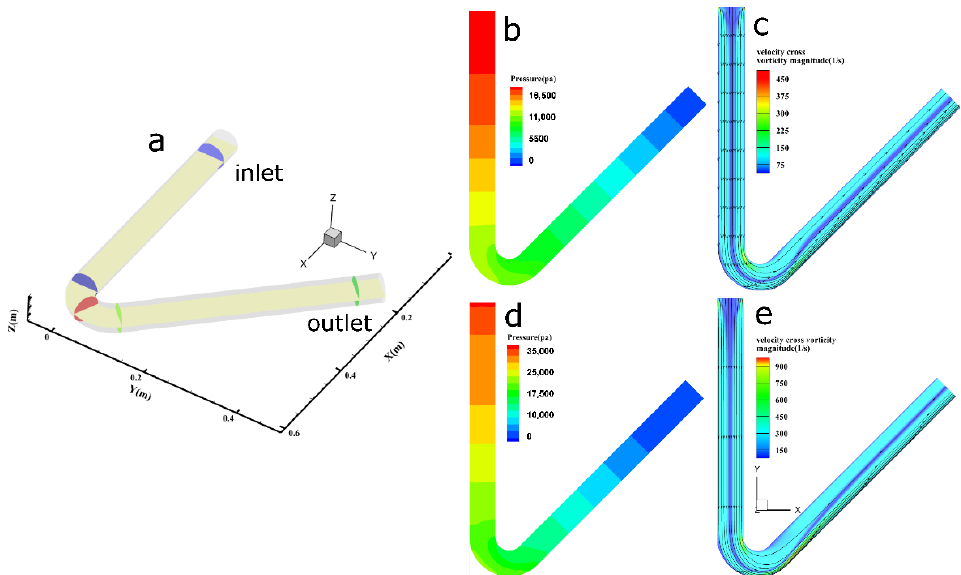
Figure 8. ( a ) Looking down at the 45° channel from an angle, the velocity, vorticity, and projected streamlines were plotted on the slices (Figures 9–12). The slices were located near the channel inlet, the bend entrance, bend core, bend exit, and the channel outlet, respectively. ( b ) The pressure distribution along the channel at the flow rate of 2.85 cm 3 /s. ( c ) The colors represent the velocity cross vorticity magnitude, which is the magnitude of the vorticity in the direction perpendicular to the velocity vectors at the same flow rate as ( b ), and the lines with arrows are the streamlines. The distribution is in the middle-height plane of the channel. ( d ) The pressure distribution along the channel at the flow rate of 4.75 cm 3 /s. ( e ) The velocity cross vorticity magnitude at the same flow rate as ( d ), and the lines with arrows are the streamlines.